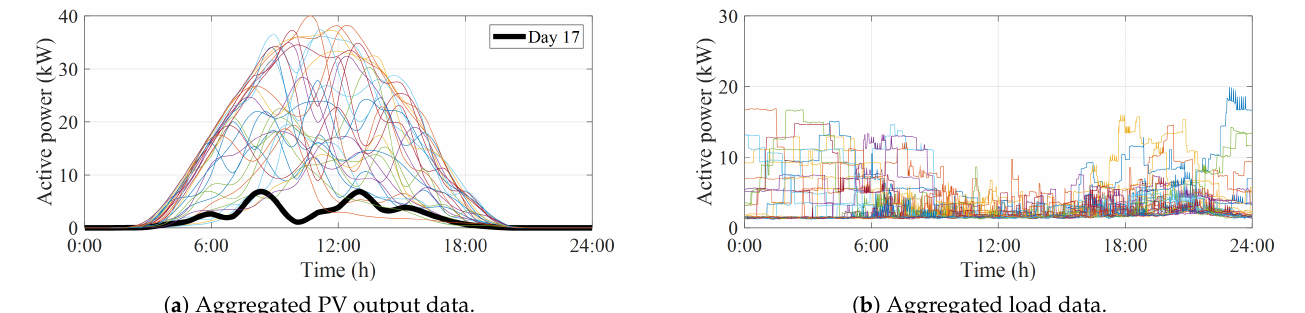
Figure 5. The 30-day time-series data in the aggregated model. The net total of them similarly corresponds to the passive part of the active power at aggregated bus P p